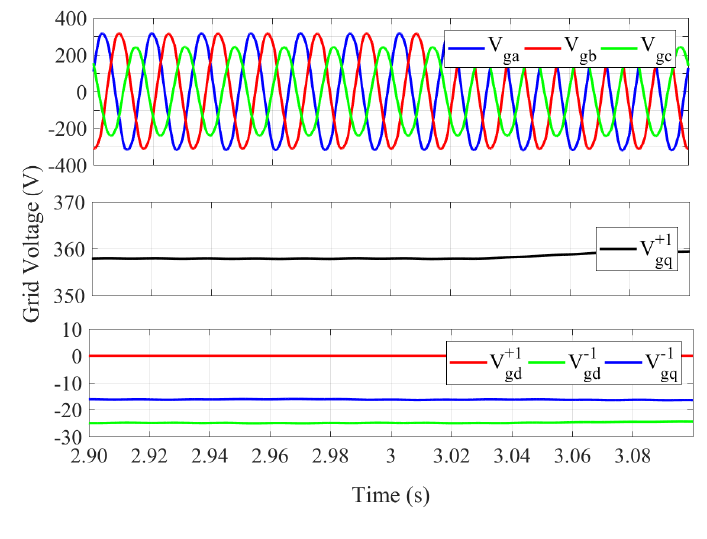
Figure 8. Voltage of the electrical network through imbalance in the phase c originated by 30 kW